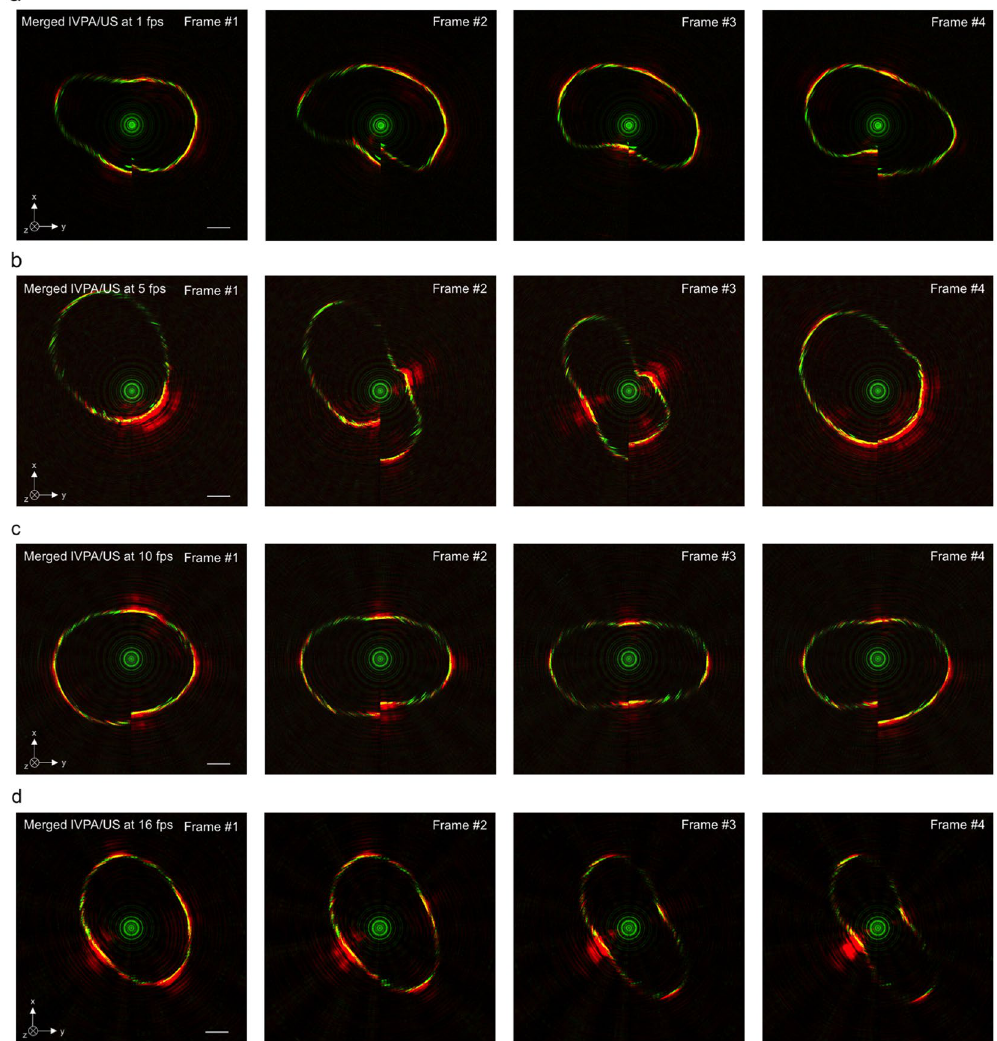
Figure 5. IVPA-US imaging of pulsatile motion at different speeds. Four consecutive IVPA-US frames selected at speed of ( a ) 1 fps, ( b ) 5 fps, ( c ) 10 fps, and ( d ) 16 fps highlighting the imaging distortion induced by pulsatile motion at lower imaging speed, while demonstrating the capability to suppress the motion artifacts at 16 fps. Complete comparison of IVPA-US imaging results at different imaging speed (1, 5, 10, 16, 20, and 25 fps) can be found in Supplementary Video S3. The depth field of view is 5.09 mm. Scale bar: 1